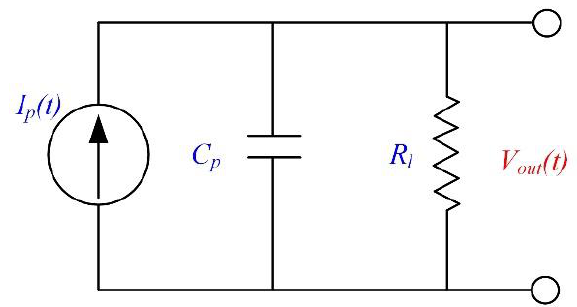
Figure 4. The schematic of the output electrical circuit model.